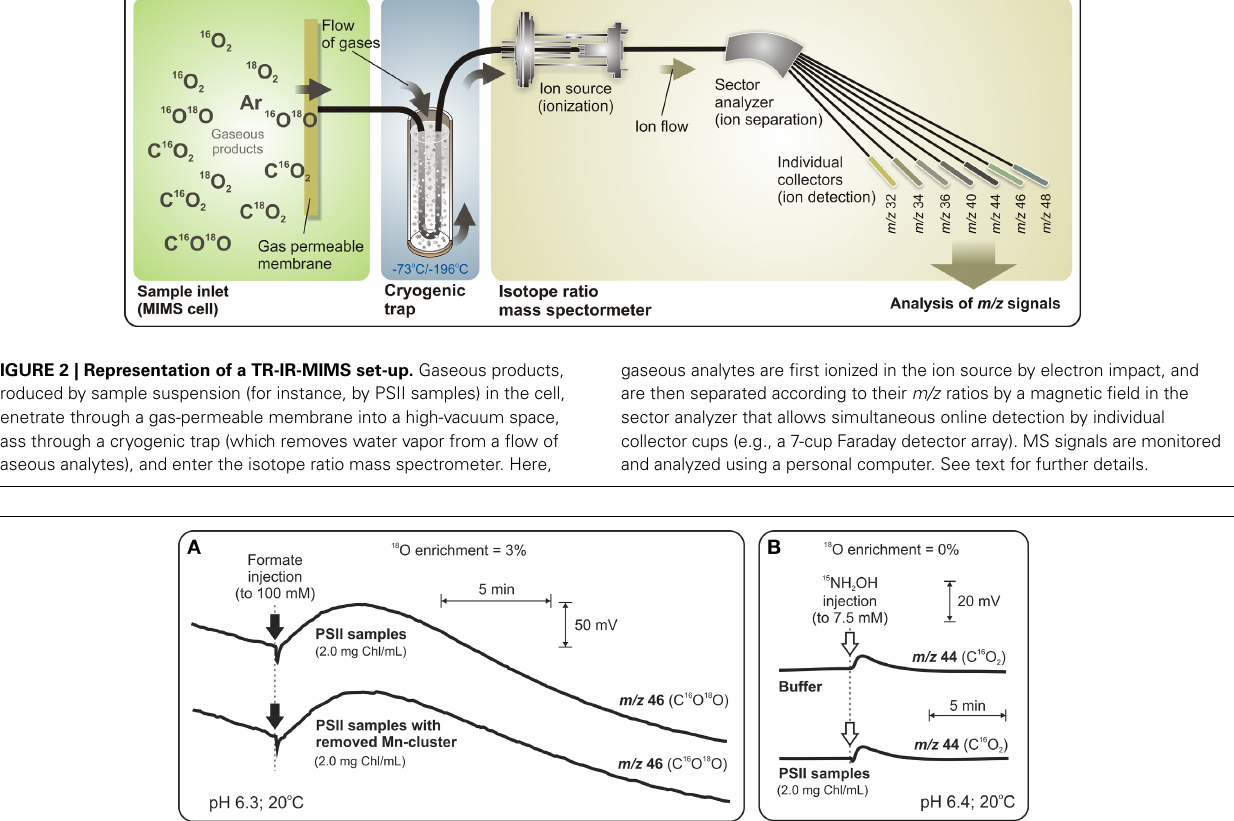
FIGURE 3 | TR-MIMS experiments demonstrating that HCO − 3 is not a tightly bound ligand to the Mn 4 CaO 5 cluster in spinach PSII membrane fragments. (A) Amount of released CO 2 upon formate addition (black arrows) to intact PSII membranes is the same as in the case of PSII membranes without the Mn 4 CaO 5 cluster (due to 75-min pre-incubation with 80mM N 2 H 4 ). Due to enrichment of sample suspension with H 18 2 O (3%) CO 2 was detected as C 16 O 18 O at m / z 46. (B) Addition of the strong reductant NH 2 OH (white arrows) at concentrations known to cause rapid